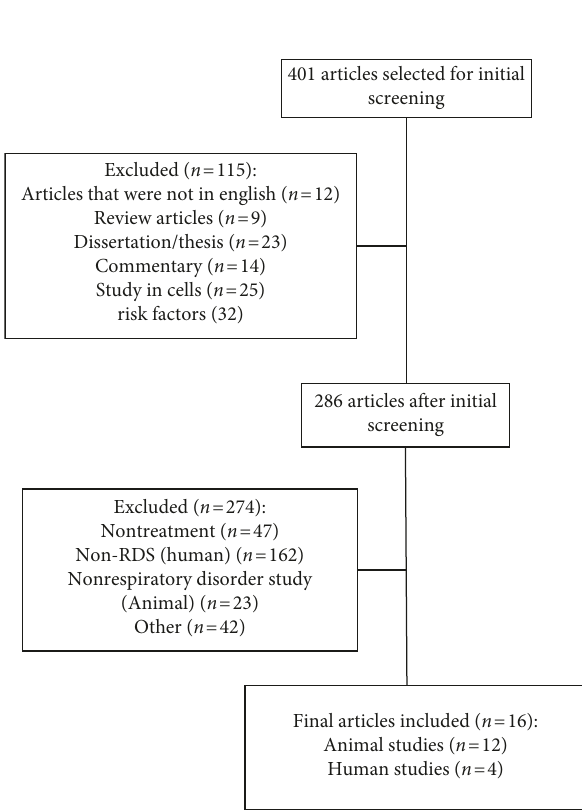
Figure 1: Flowchart of the literature